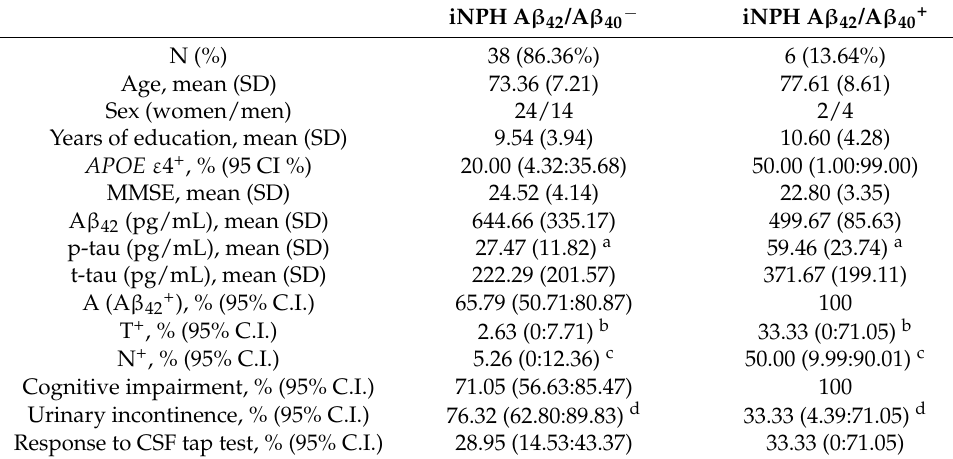
Table 5. Comparison of demographic variables and CSF biomarkers values between iNPH A β 42 /A β 40 − and iNPH A β 42 /A β 40+